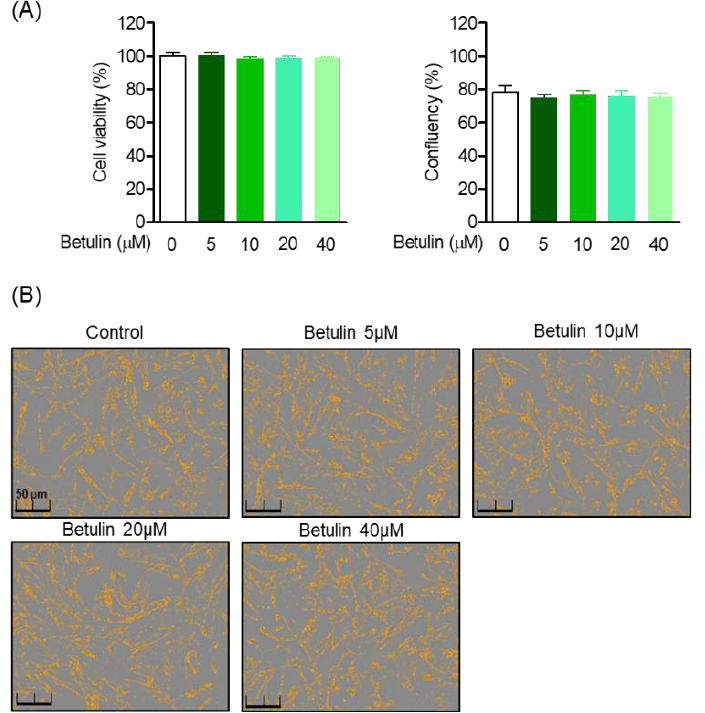
Figure 2. Effects of betulin on HPDL cells cytotoxicity and confluency. HPDL cells were seeded 1 × 10 4 cell/mL for 24 h, then after treatment with each indicated concentration (5 – 40 μM) of betulin for 24 h, cell viability was analyzed through MTT assay ( A ). The cell confluents were analyzed using the Incucyte ® Live-Cell assay system to marked the cell confluency of normal cells ( B ).